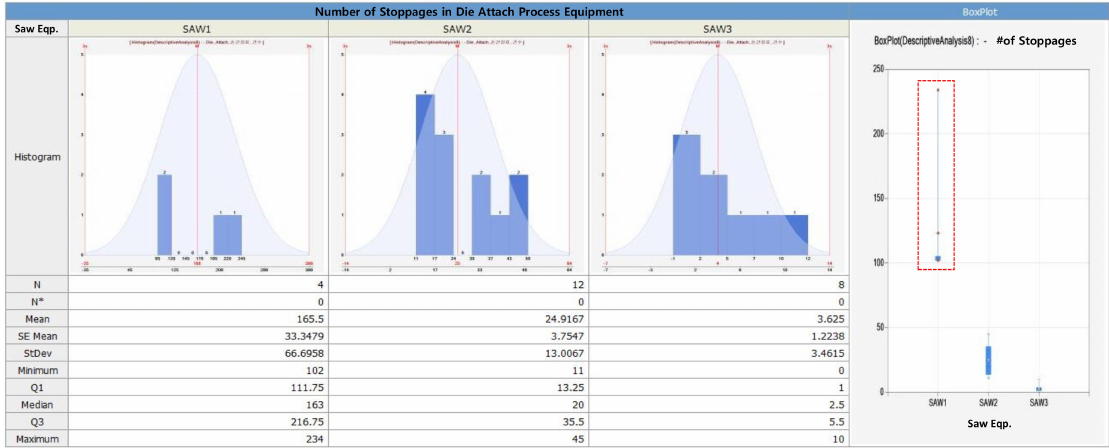
Figure 6. Descriptive statistical analysis results between the die attach equipment faults and wafer sawing equipment.